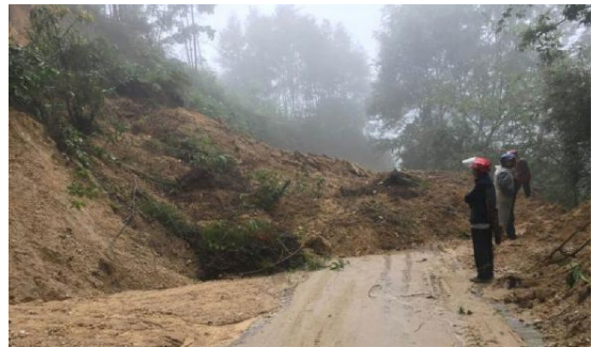
Figure 1. Mountain landslide blocking